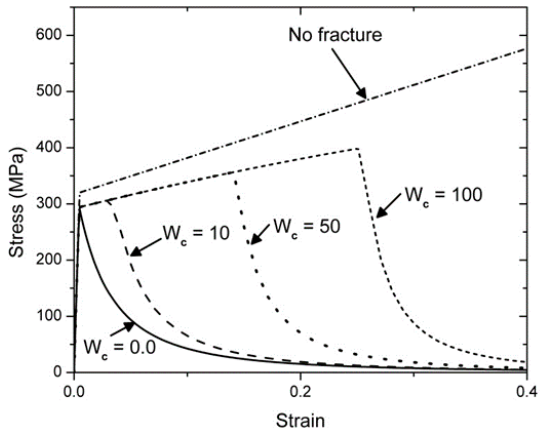
Figure 1. Stress ‐ strain response using the rate ‐ independent model, (cid:2020) (cid:3404) 0 for different values of the plastic work threshold. plastic work